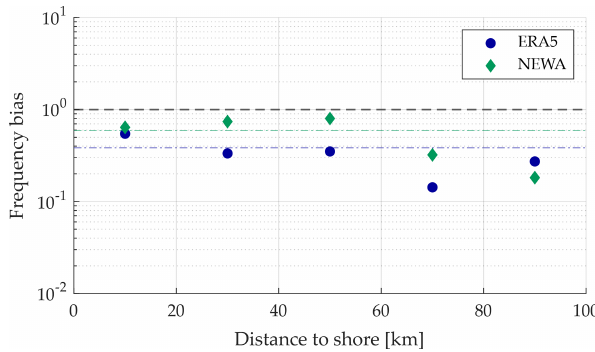
Figure 10. Bin-averaged frequency bias (FBIAS) of low-level jets for the two numerical models against distance to shore (20km bins width were used). The dash-dotted lines represent the average fre- quency bias for the complete dataset. Black dashed line represent a perfect score (FBIAS = 1).